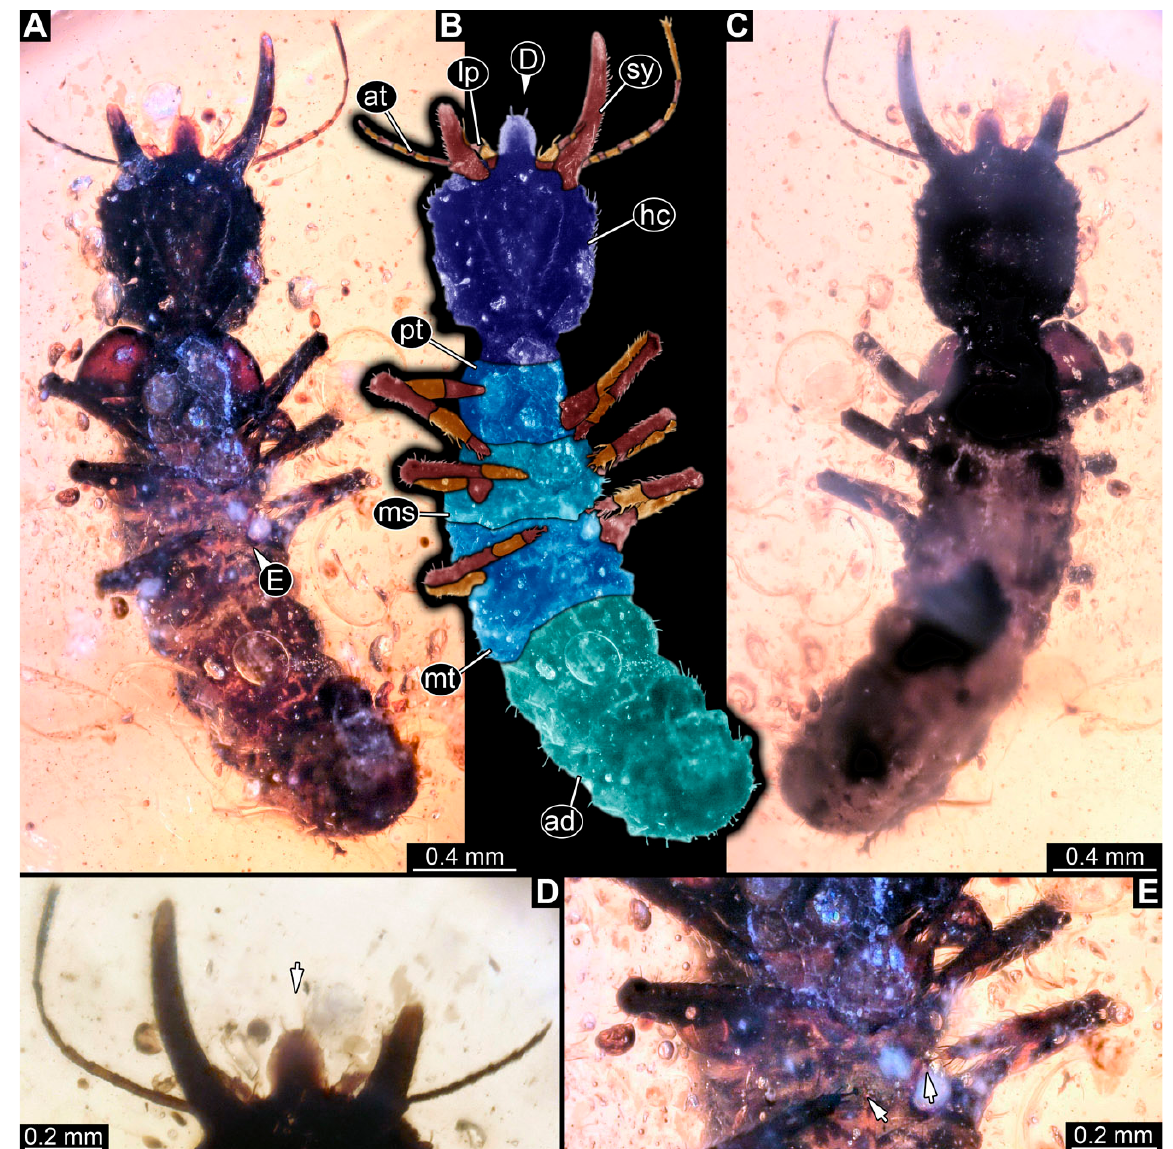
Figure 17. Specimen 78 (PED 1703); Myanmar amber. ( A ) Ventral view. ( B ) Ventral view, colour- marked. ( C ) Dorsal view. ( D ) Close-up of labrum in dorsal view; arrow marks labrum. ( E ) Close-up of locomotory appendages; arrows mark empodia. Abbreviations: ad = abdomen; at = antenna; hc = head capsule; lp = labial palp; ms = mesothorax; mt = metathorax; pt = prothorax; sy = stylet. (27) Specimen 79 (PED 1726) is preserved in Cretaceous Myanmar amber (Figure 18).